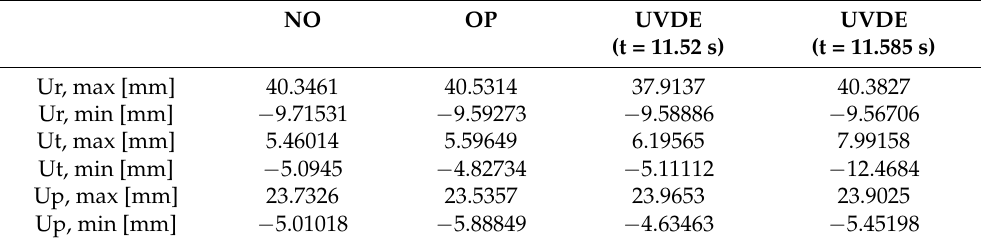
Table 5. Maximum and minimum displacements values obtained.